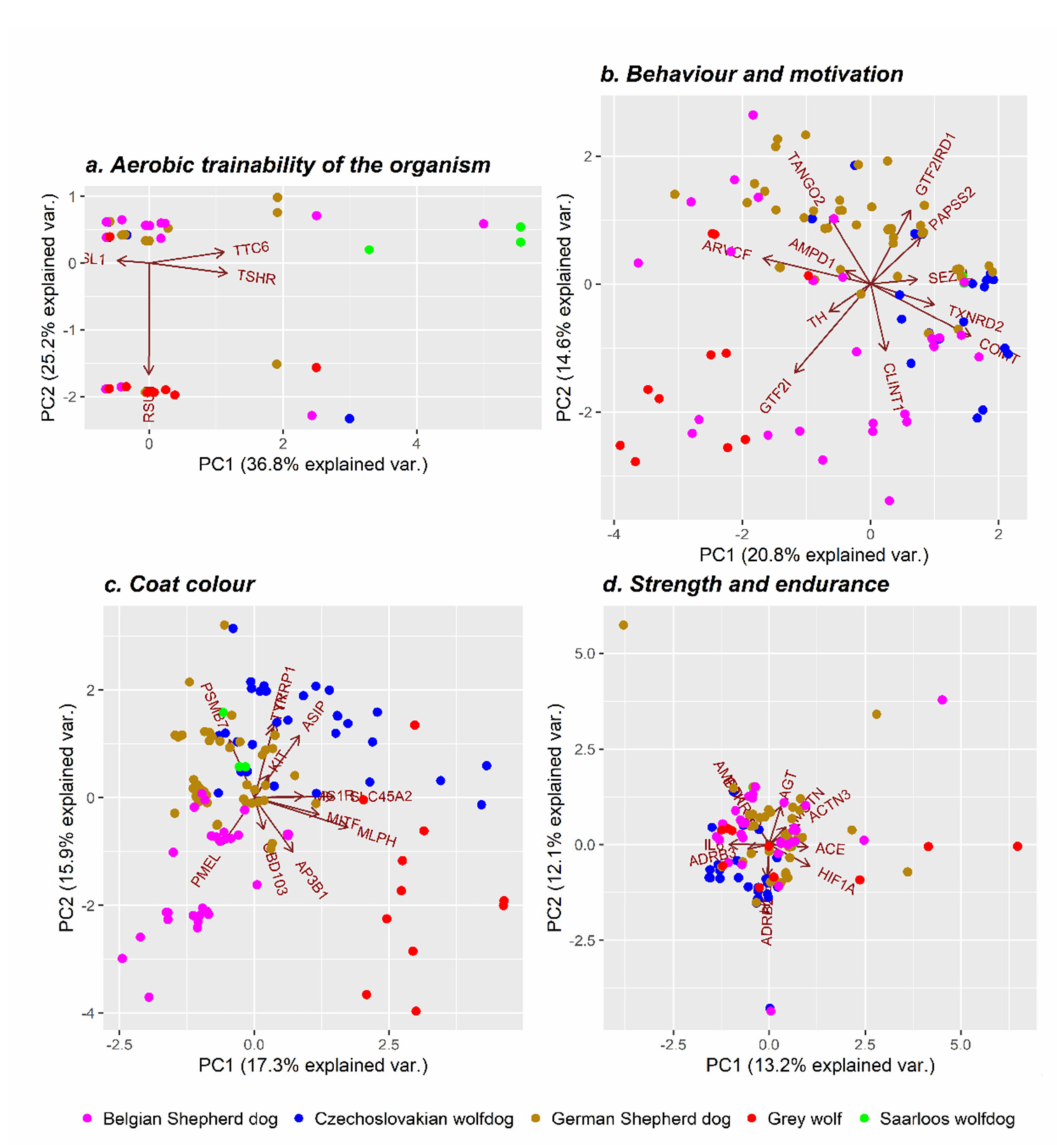
Figure 4. Population differentiation based on variants near genes of relevance for the selected phenotypic traits (aerobic trainability of the organism ( a ), behaviour and motivation ( b ), coat colour ( c ), and strength and endurance ( d